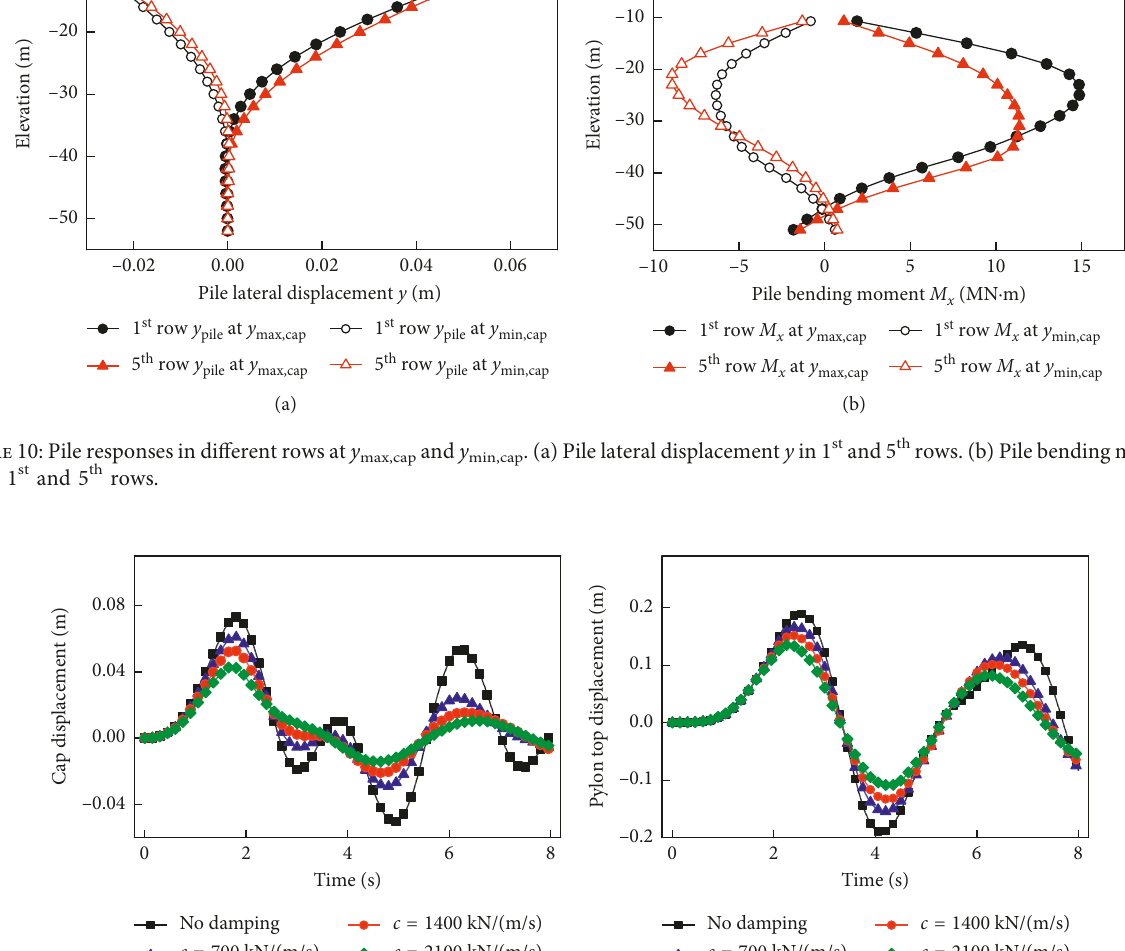
Figure 11: Bridge pylon lateral displacements for various soil damping in SPI. (a) Cap lateral displacement. (b) Pylon top lateral